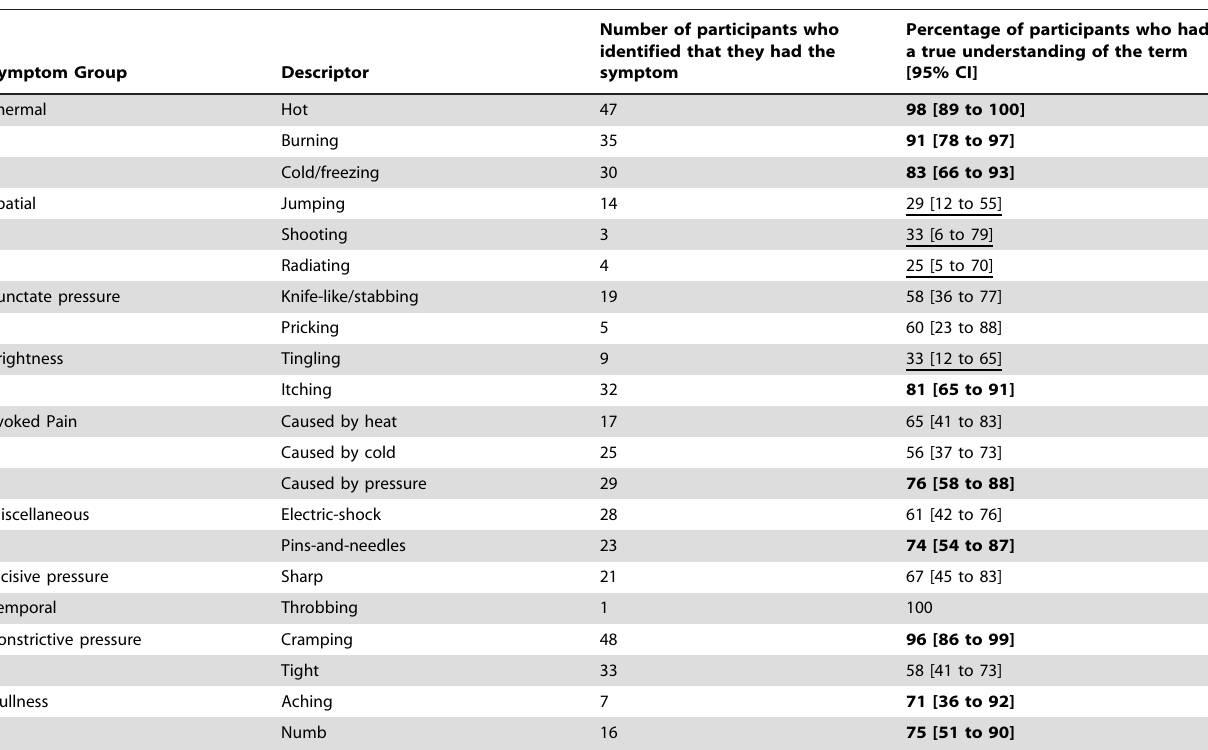
Table 5. Level of understanding of English-language neuropathic symptoms.